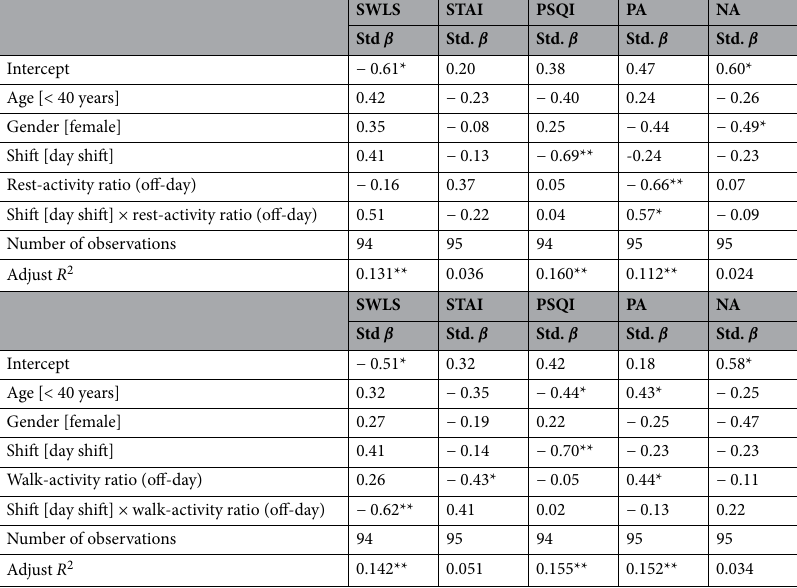
Table 3. Results from the linear regression models to predict daily self-report variables using the physical activity features. Statistical significance is denoted with ** p < 0.01 , * p < 0.05 .